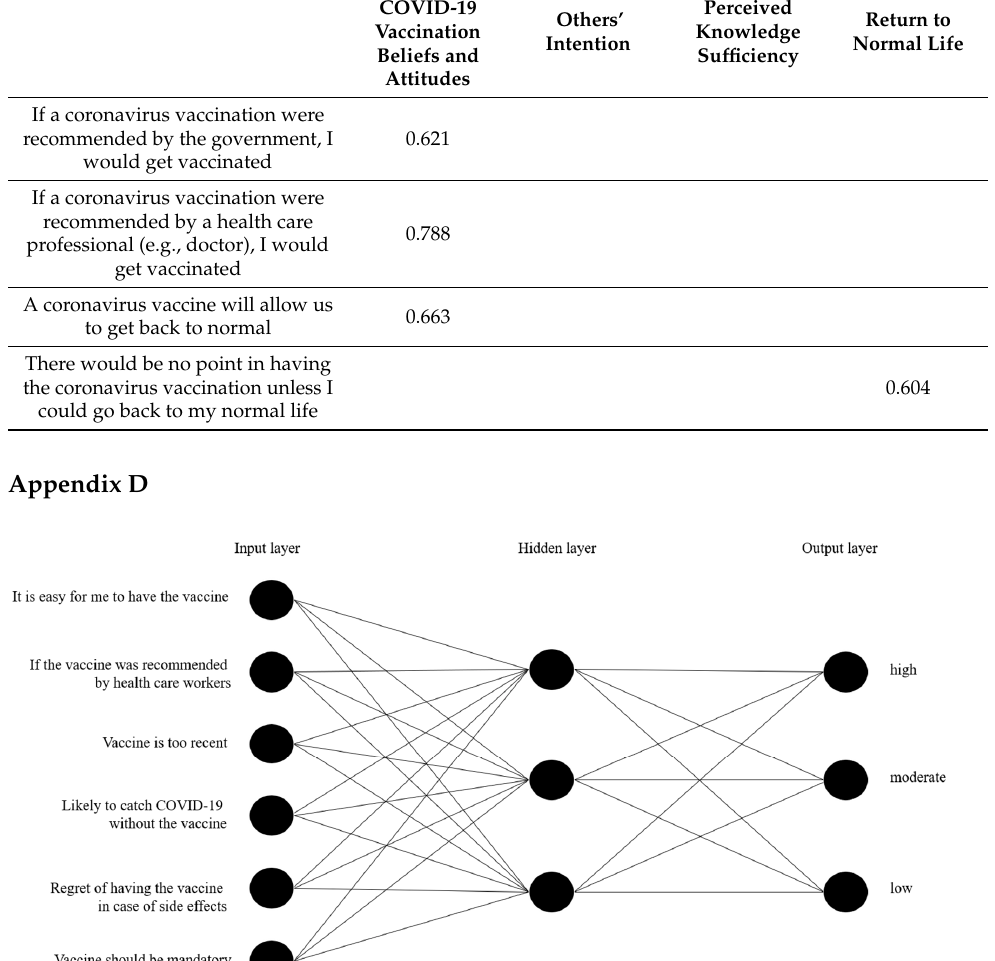
Table A4. Confusion matrix for the predicted vs. real values in the testing set. Predicted Low Moderate High